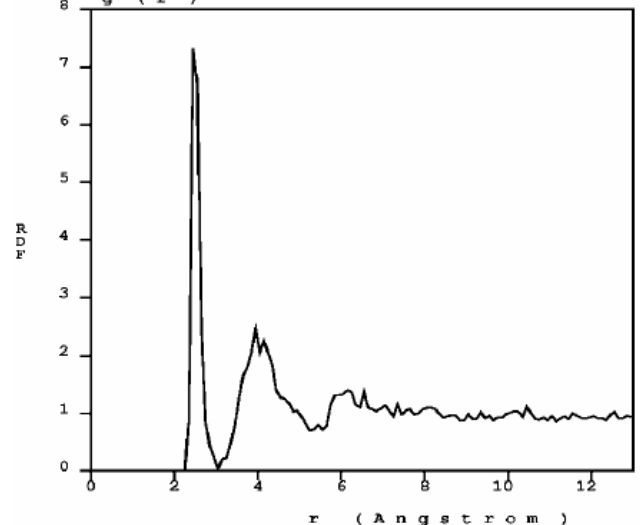
Figure 8. RDF for nanoporous silicon. The atomic topology is more typical of an